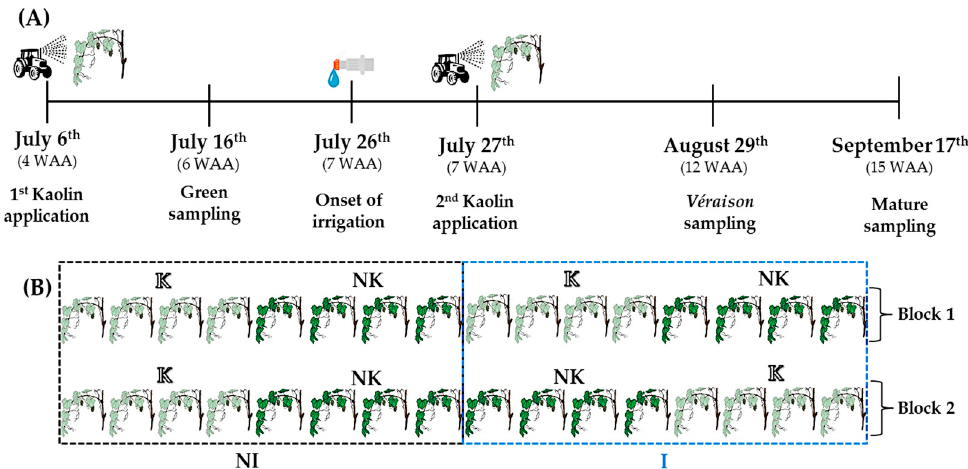
Figure 1. ( A ) Timeline of the grape growing season depicting the sampling times, foliar kaolin application dates, and the onset of irrigation. ( B ) Scheme of treatment combinations applied in the field: irrigation (I) / non-irrigation (NI) × kaolin (K) / non-kaolin (NK). (WAA - weeks after